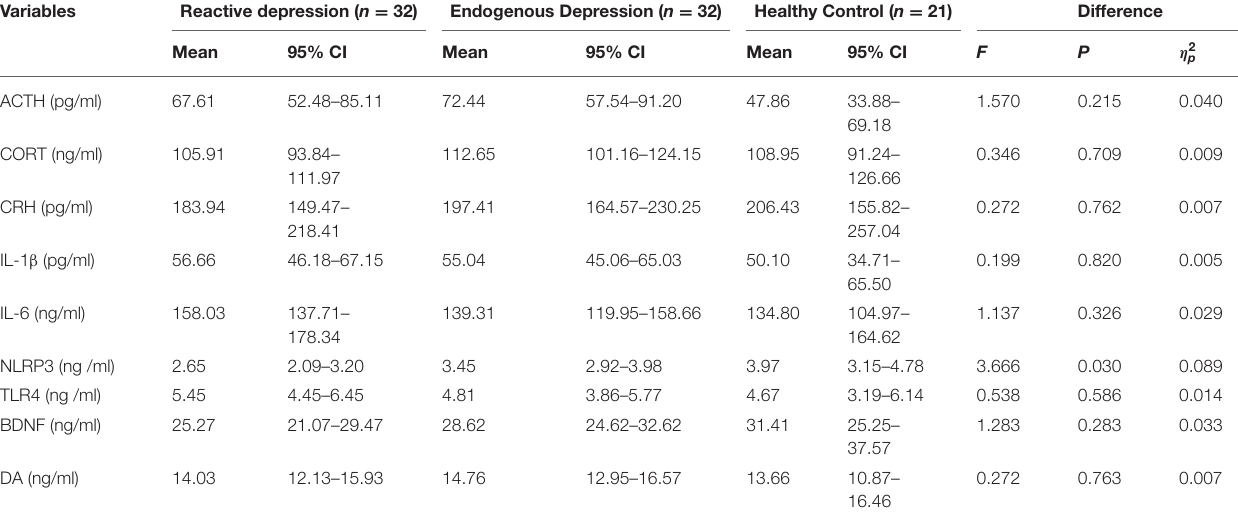
TABLE 2 | Comparison of serum biological indicators expression levels in different groups. Variables Reactive depression ( n = 32) Healthy Control ( n =